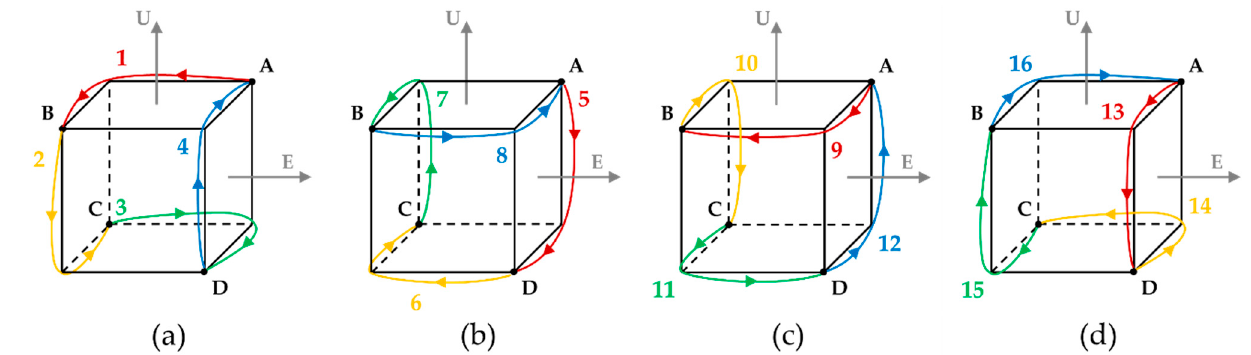
Figure 1. ( a ) Rotation sequence 1~4; ( b ) rotation sequence 5~8; ( c ) rotation sequence 9~12; ( d ) rotation sequence 13~16.